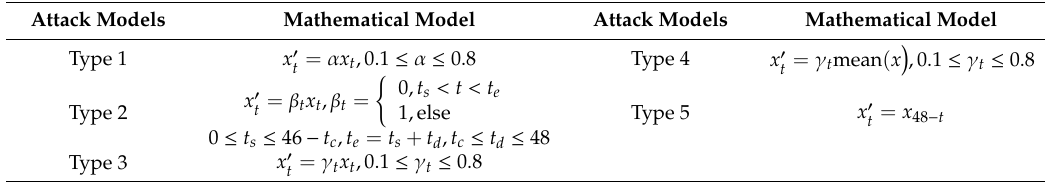
Table 1. Mathematical formulas of di ff erent attack models.